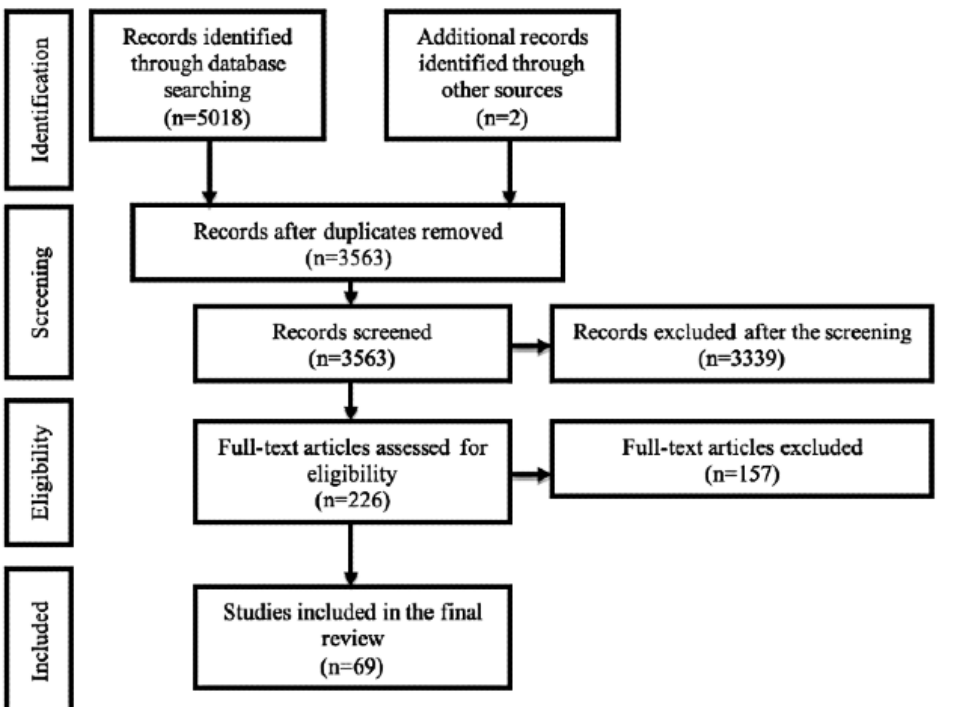
Figure 1. Preferred Reporting Items for Systematic Reviews and Meta-Analyses flow